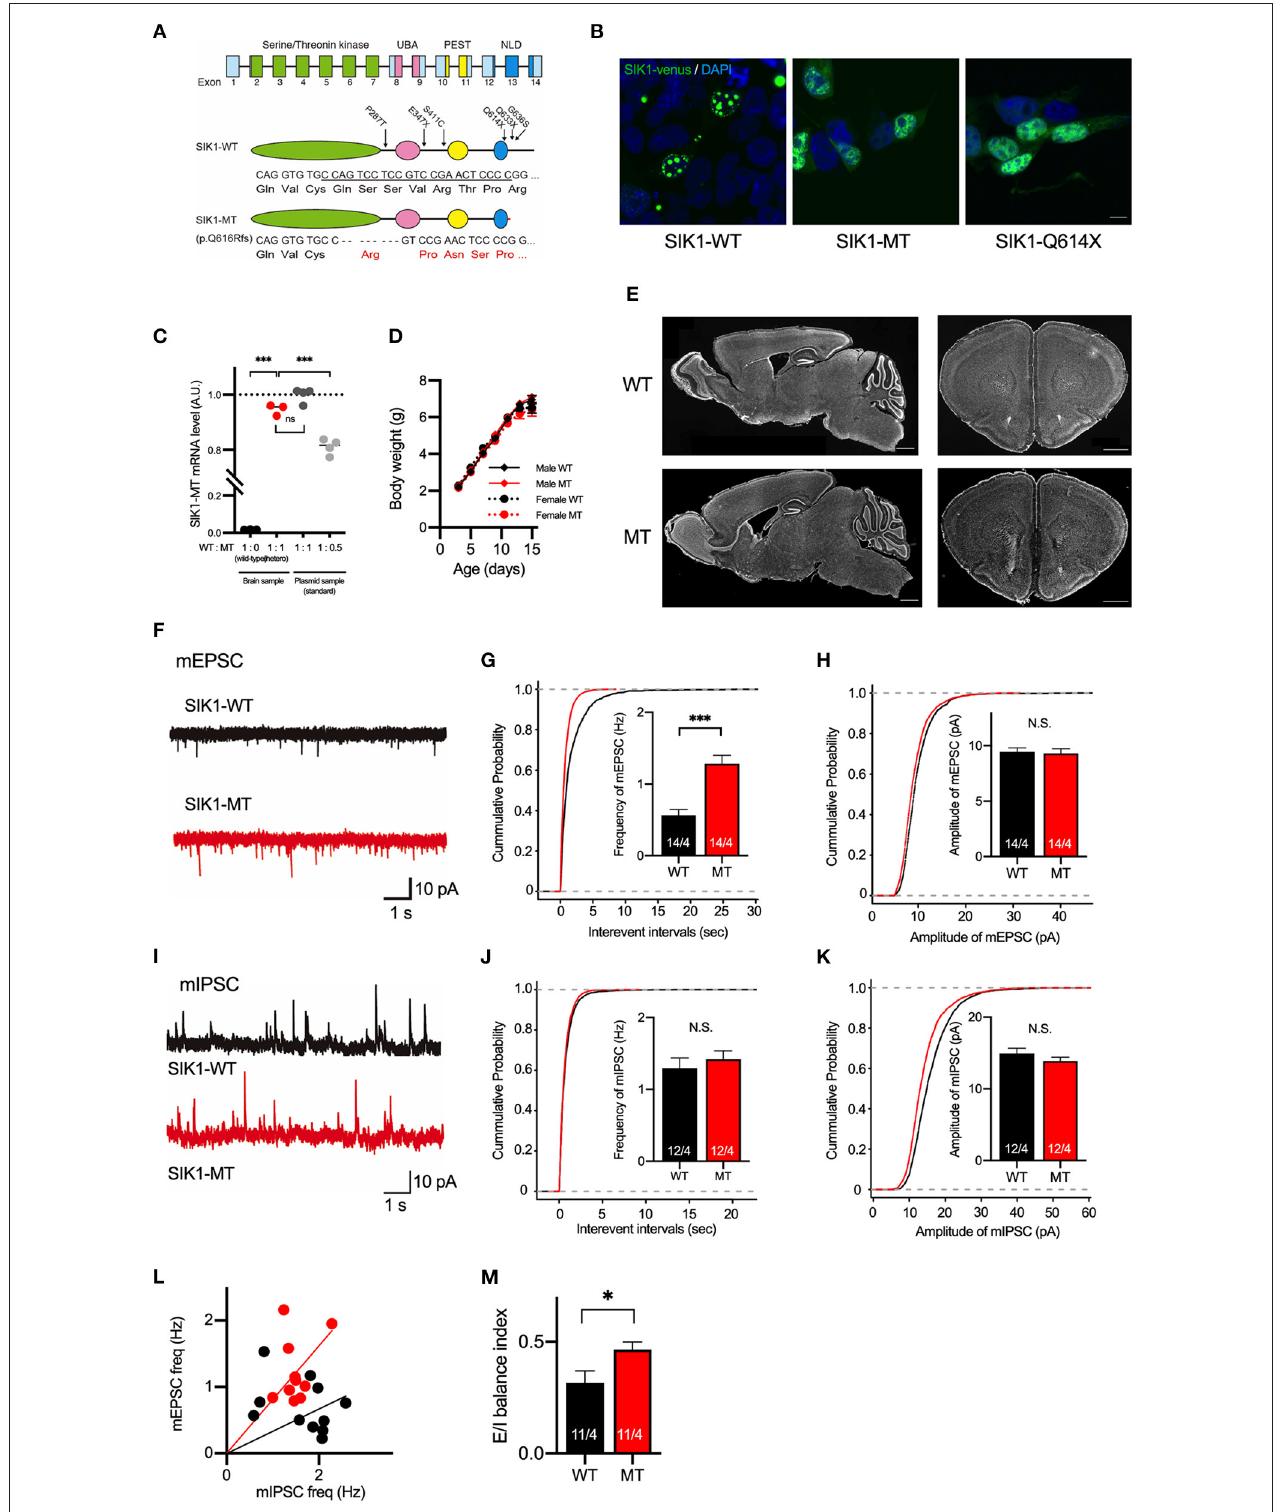
FIGURE 1 | Generation and basic characterization of the SIK1 MT mice. (A) Genomic organization of SIK1 gene (top), domain structure of wild-type (middle), and mutant SIK1 (bottom) protein. The locations of the mutations identified in human patients are indicated on the domain structure of SIK1-WT. Nucleotide and amino